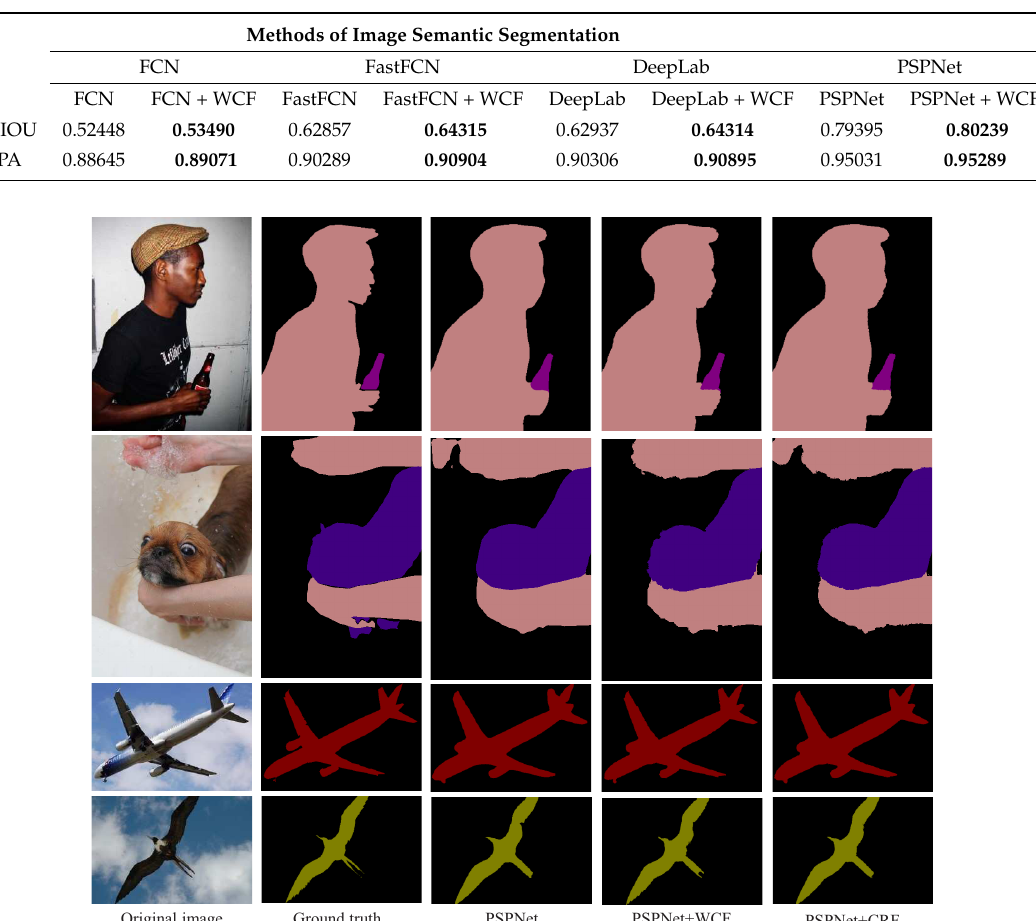
Table 1. Comparison of enhancement results of four semantic segmentation algorithms.